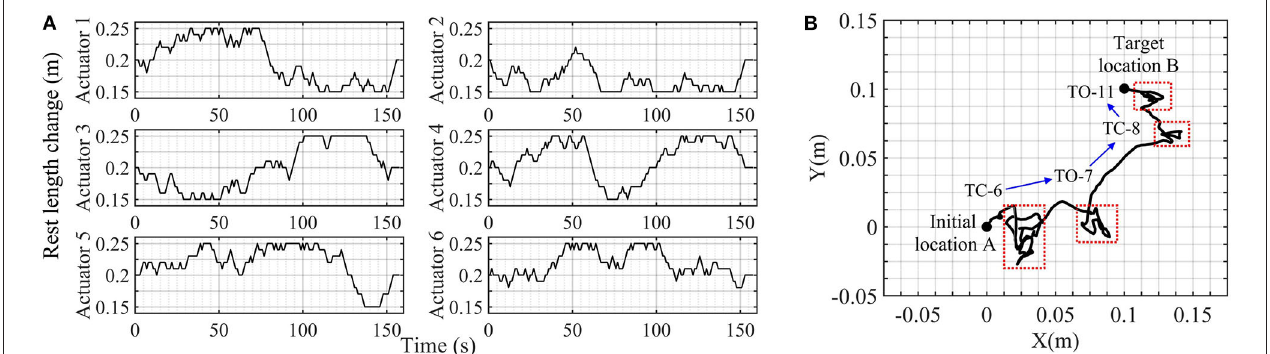
FIGURE 10 | Optimal solution: (A) control strategy and (B) motion path.